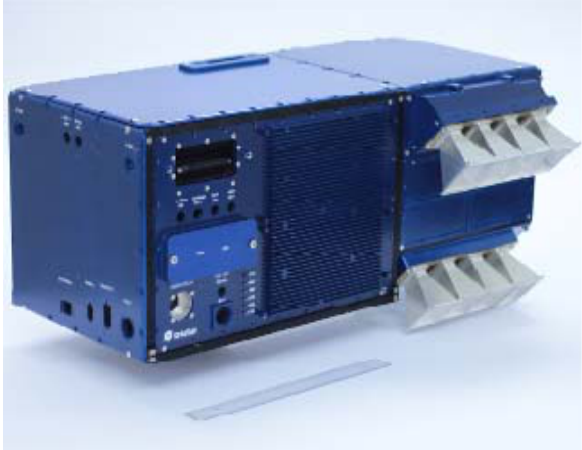
Figure 2: X- and P-band synthetic aperture